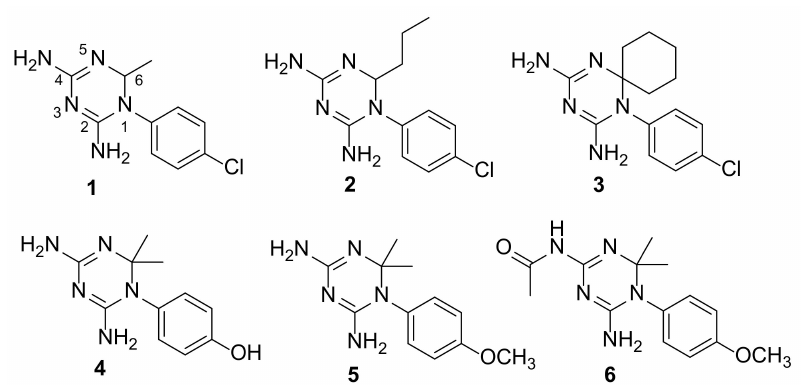
Figure 4. Chemical structures of CYC analogues 1–6